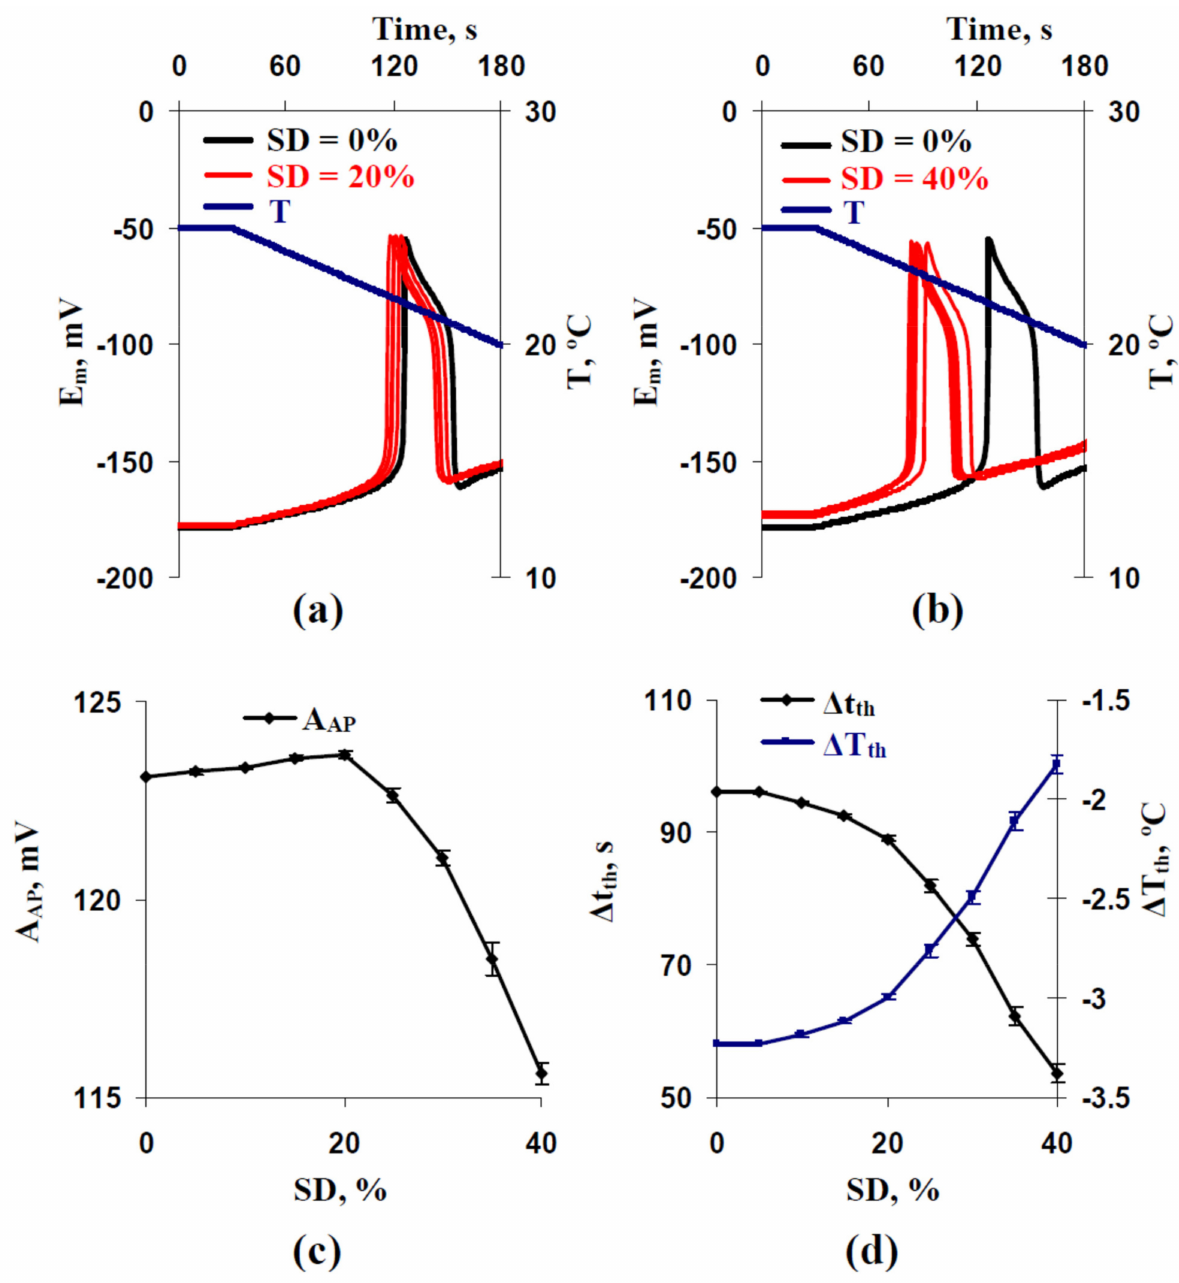
Figure 3. Examples of simulated changes in the membrane potential (E m ) induced by a decrease of temperature (T) with a 2 ◦ C min − 1 rate at the standard deviation of initial H + -ATP-ase activity in cells (SD) equaling to ( a ) 20% and ( b ) 40%. ( c ) Dependences of the averaged amplitude of the first action potential (A AP ) and ( d ) its time and temperature thresholds ( ∆ t th and ∆ T th , respectively) on SD. Parameters of cooling-induced changes in E m at SD = 0% were used as a control. Only five repetitions are shown in ( a , b ). Averaged parameters (A AP , ∆ t th , and ∆ T th ) shown in ( c , d ) were calculated on the basis of 25 repeated